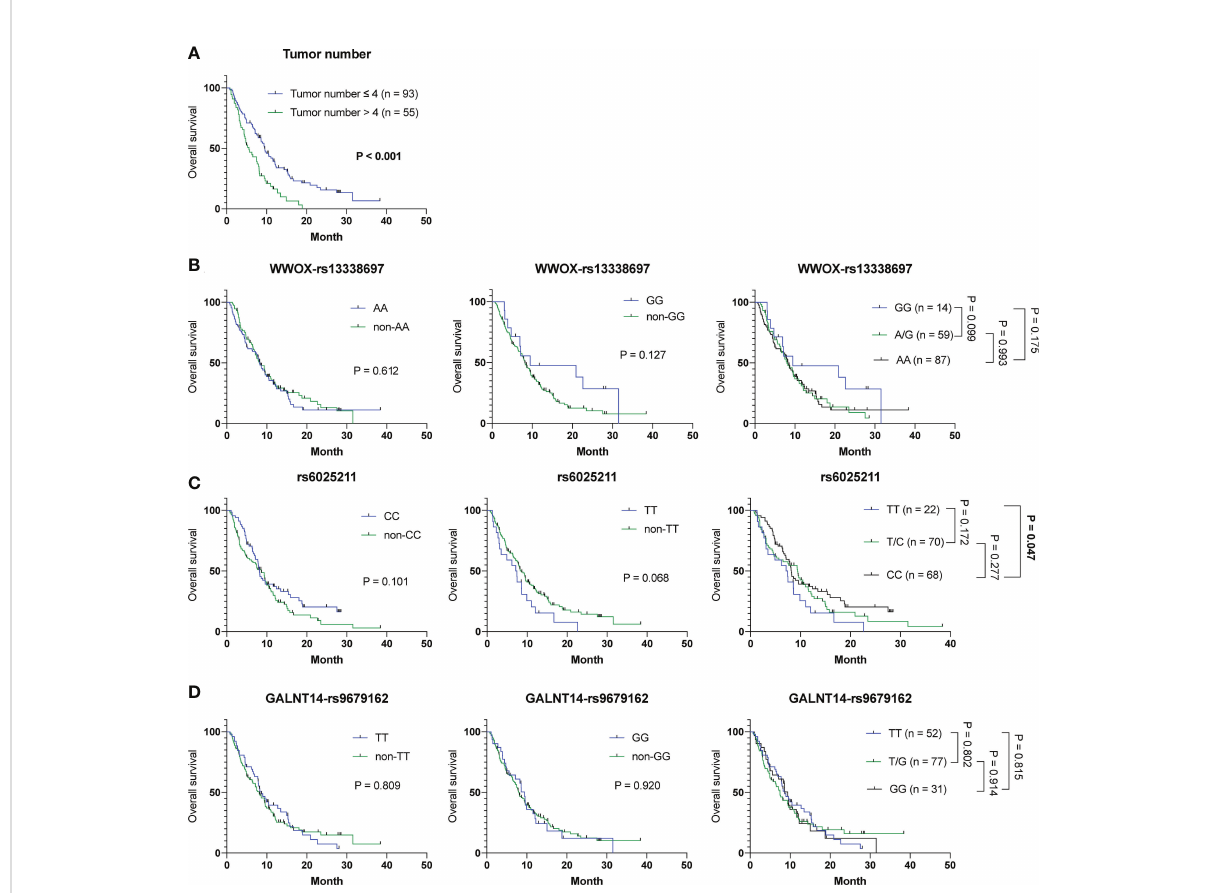
FIGURE 3 Analysis of clinicopathological factors and SNP genotypes in association with OS in all 160 HCC patients experiencing ADI-PEG 20 therapy. Kaplan-Meier analysis of subgroups of patients with HCC strati fi ed by (A) tumor number, (B) WWOX -rs13338697, (C) rs6025211, and (D) GALNT14 -rs9679162 genotypes. P values were obtained by log-rank test, and < 0.05 was considered signi fi